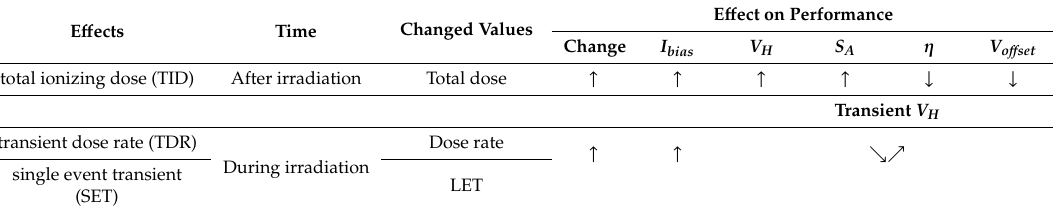
Table 3. Radiation effects on performance of FD-SOI Hall sensor 1 .